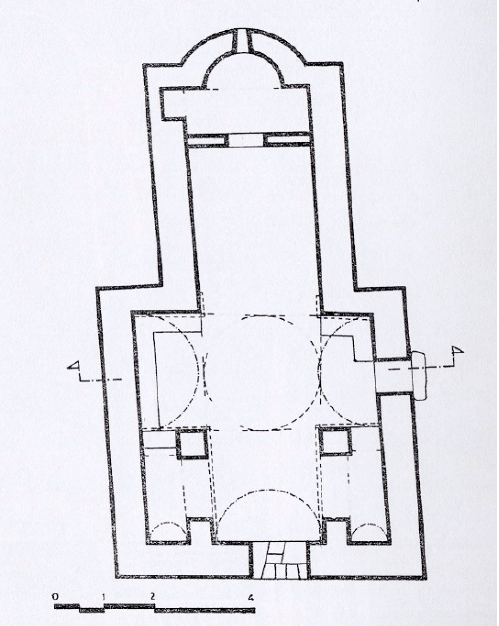
Figure 20. Ground plan of the church of Hagios Nikolaos Mavrikas (Aegina). Source: ( Μουτσόπουλος